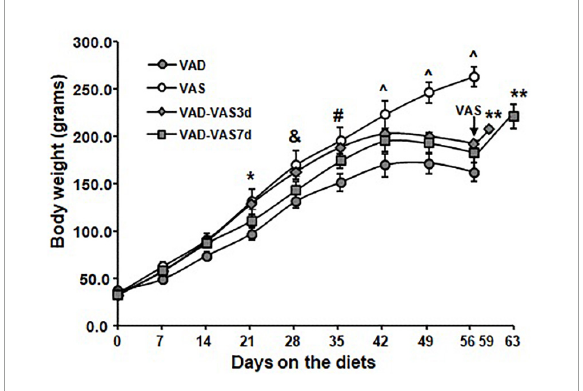
FIGURE1 The body weight (BW) of Zucker lean (ZL) rats fed a vitamin A sufficient (VAS), a vitamin A deficient (VAD) diet for 8 weeks, or those fed a VAD diet for 8 weeks and followed by the VAS diet for 3 (VAD-VAS3d) or 7 (VAD-VAS7d). Mean ± SEM, n = 8 for each group; * For VAD < VAS, & for VAD/VAD-VAS7d < VAD-VAS3d/VAS; # for VAD and VAD-VAS7d < VAS and VAD < VAD-VAS3d, ˆVAD < VAD-VAS3d < VAS and VAD-VAS7d < VAS using